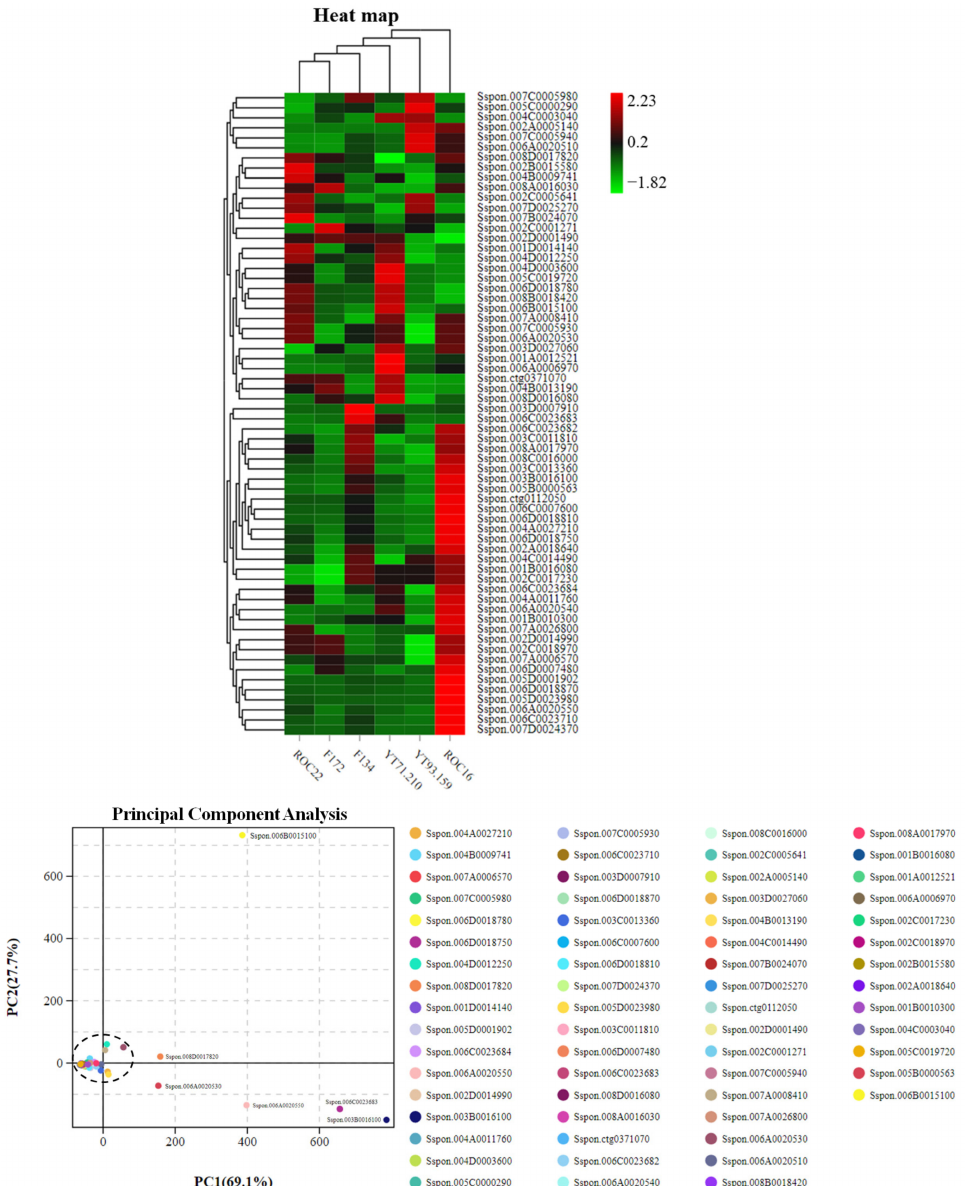
(Figure 5). The scattered plot displayed higher absolute score values on the PC1 x -axis (69.1%) and PC2 y -axis (27.7%) (Figure 5). The variety-wise histogram was